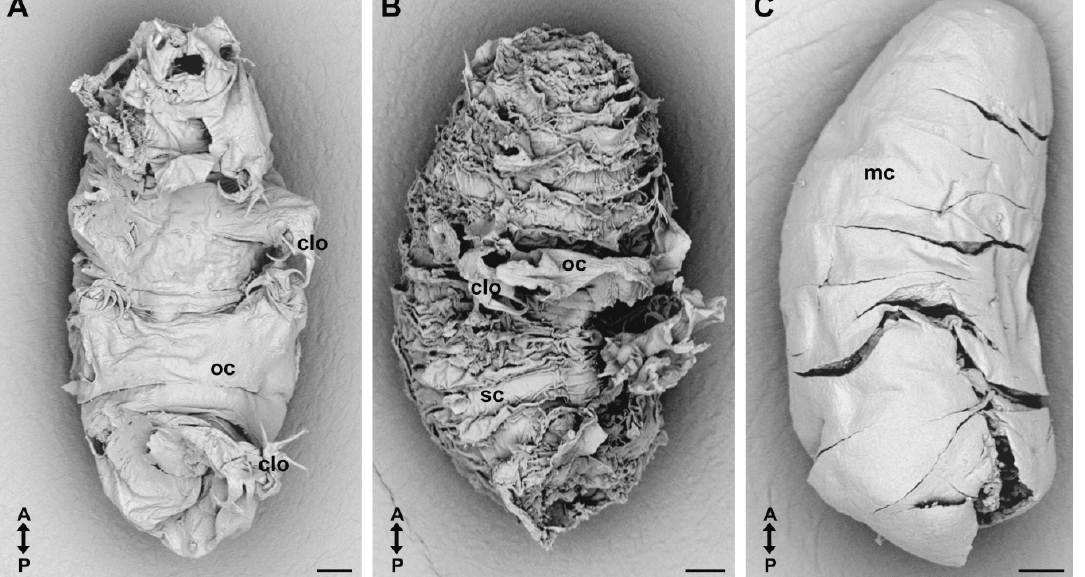
Figure 4. Cuticular capsule of the cyst, BF. ( A–C ) Cross ‐ section through the cyst; ( D–G ) empty cuticular capsules; ( C–F ) legs of the sarcophagus cuticle; ( C ) cross ‐ section through the leg of the sarcophagus cuticle; ( D ) fourth leg of the sarcophagus cuticle; ( E ) legs of the sarcophagus cuticle,